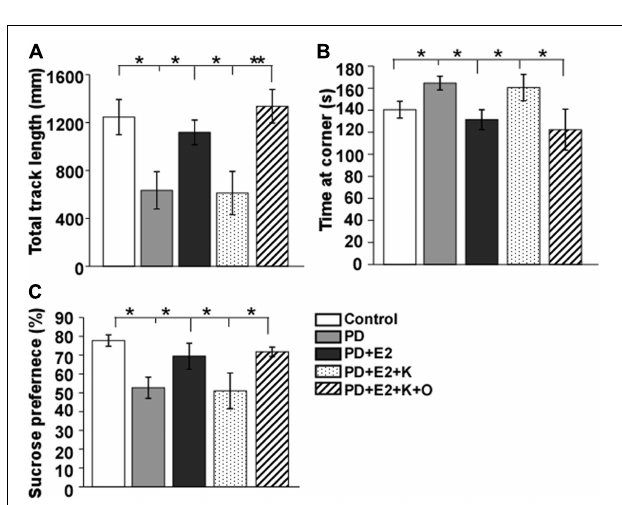
FIGURE 3 | Histograms showing statistical analysis of the total track length (A) and time at the corner in the open field test (B) and the percentage of sucrose solution Consumption (C) . Results are presented as mean ± SEM. ( n = 8, each group). * p < 0.05; ** p <